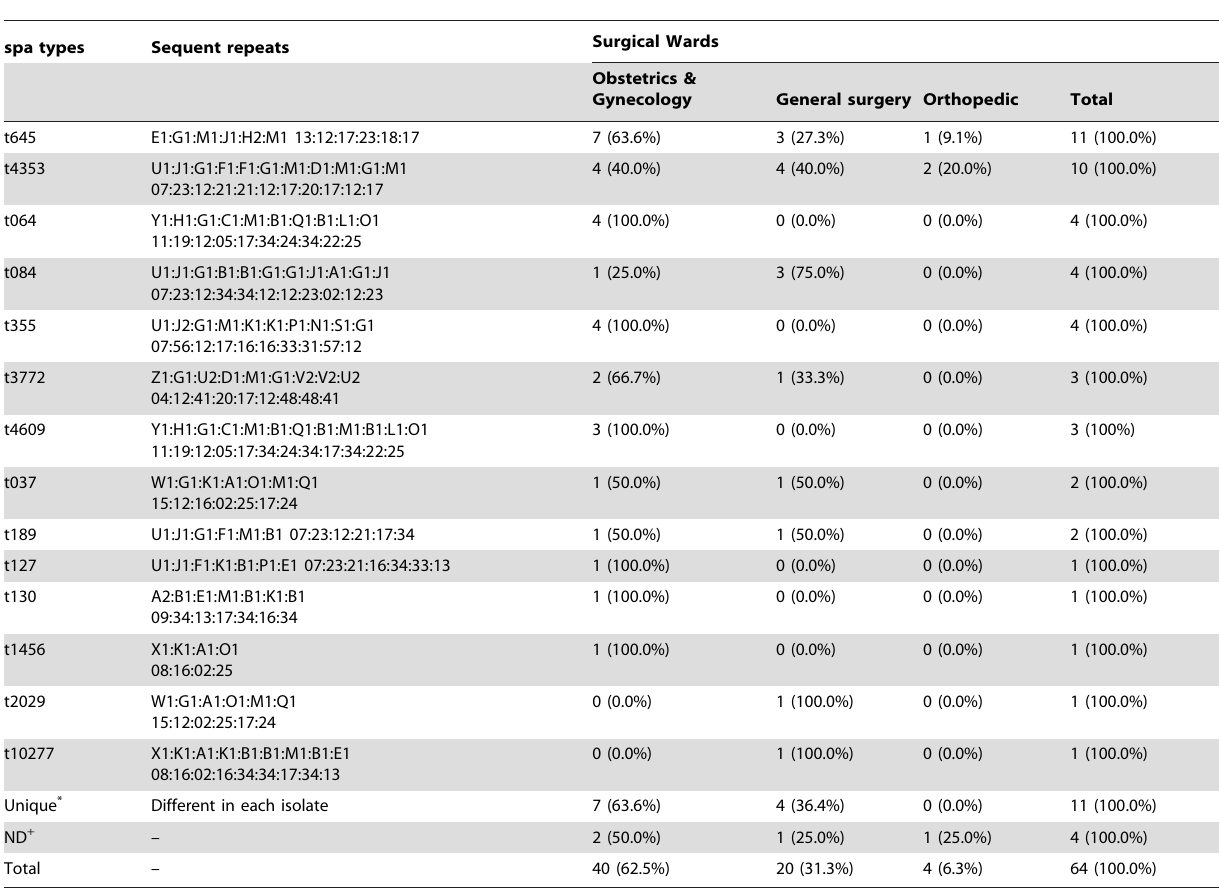
Table 2. Genetic lineages of S. aureus based on spa typing and their distribution in different wards.